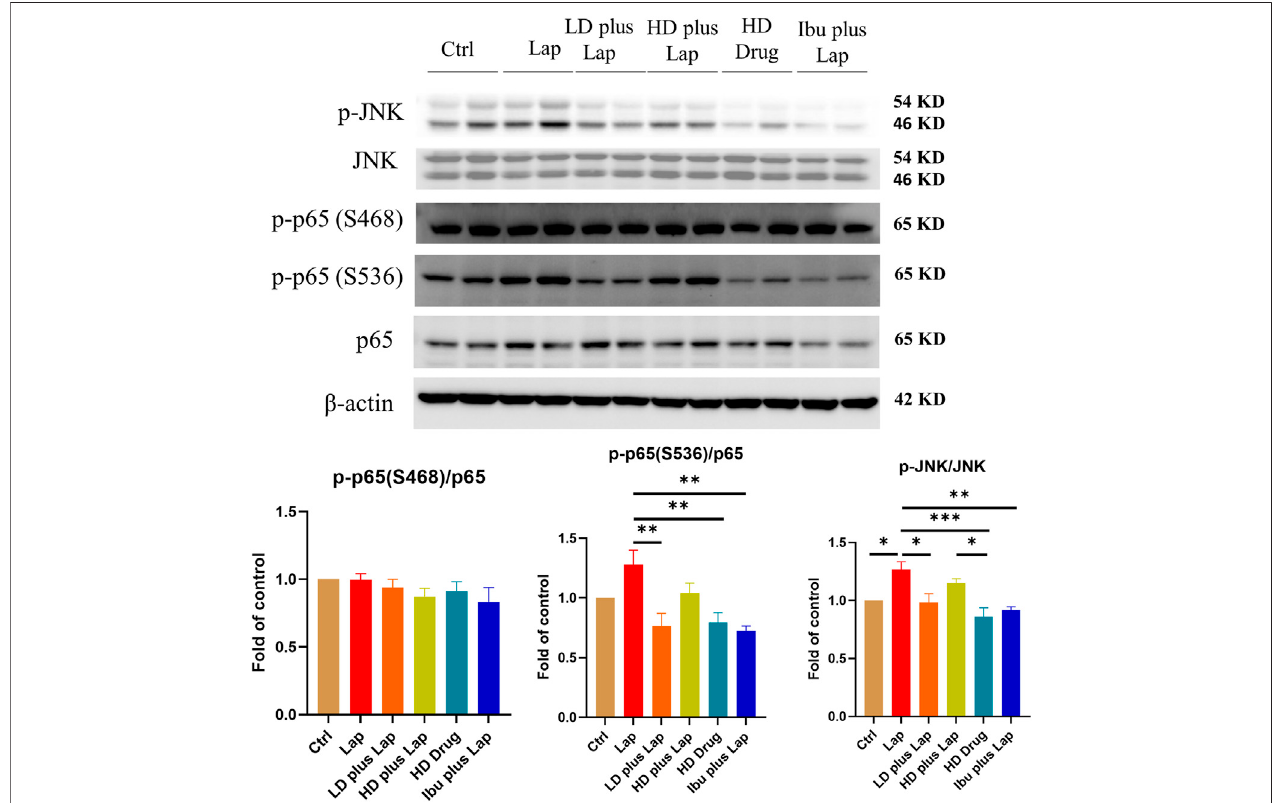
FIGURE 7 | D101 fraction inhibited activation of JNK and NF-kB in the hippocampus of postoperative mice. Inhibition of JNK and NF-kB pathway after D101 fraction treatment in postoperative mice. An increase in phosphorylated JNK and p65 was found in the hippocampus after surgery and D101 fraction signi fi cantly inhibitedthisup-regulation. DataarepresentedasthemeanandSEM( n =4 – 5)and represents thebanddensitiesthatwerenormalized withendogenousJNK,p65and β -actin ,respectively. * p < 0.05, ** p < 0.01,*** p < 0.001comparedwiththelaparotomy group.Values wereanalyzed byone-wayANOVA withTukey posthoc test.